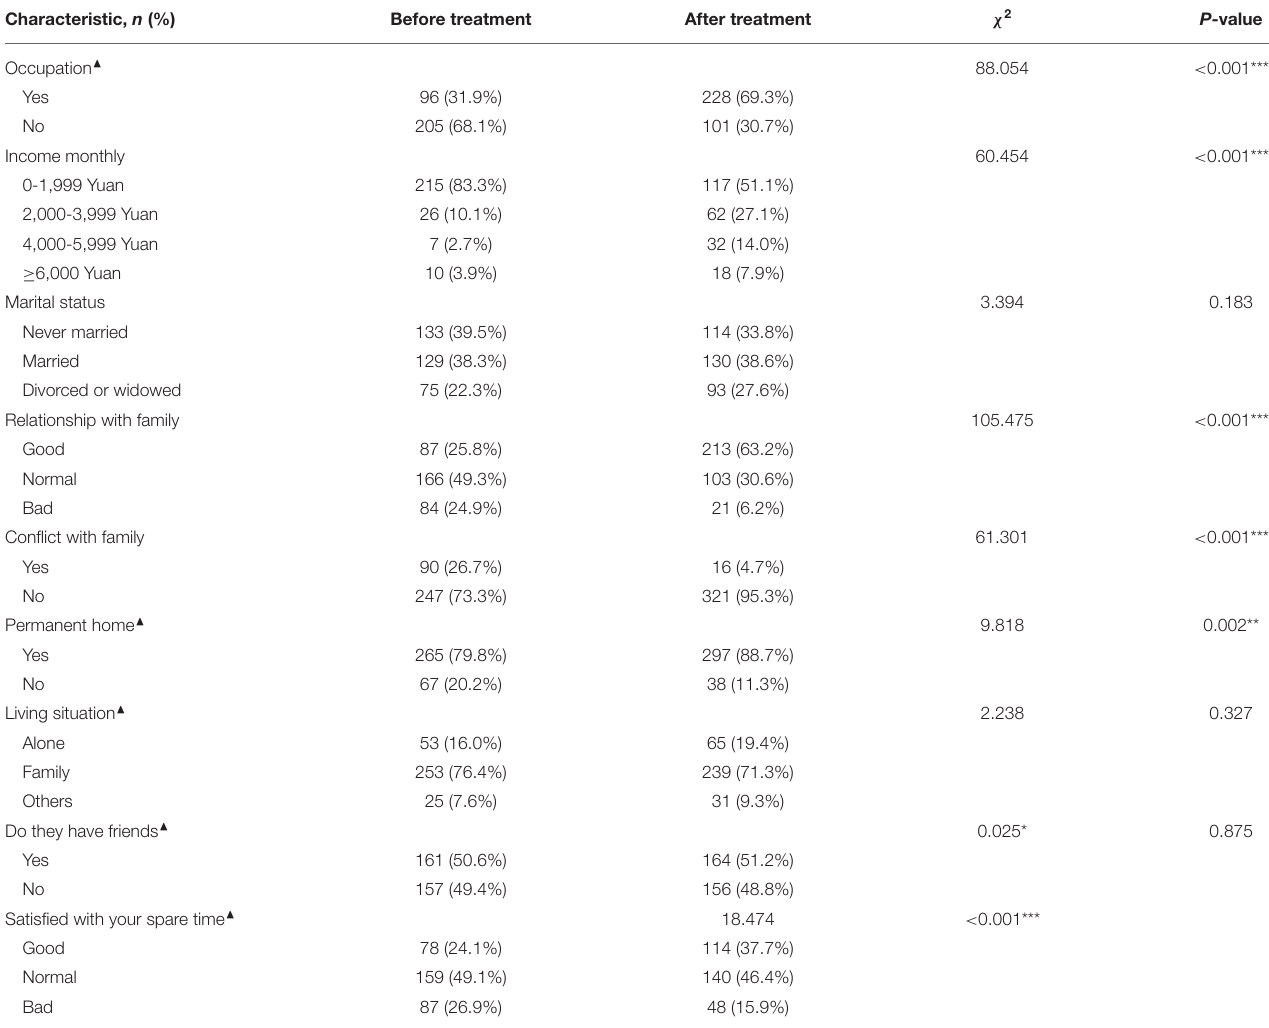
TABLE 2 | Comparison of related factors before and after rehab in CRCs. Characteristic, n (%) Before treatment After